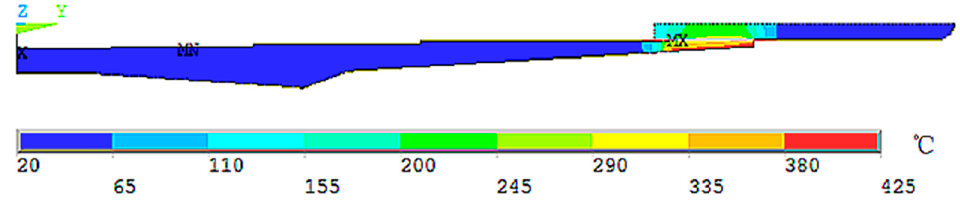
Figure 3. Steady-state temperature distribution diagram.